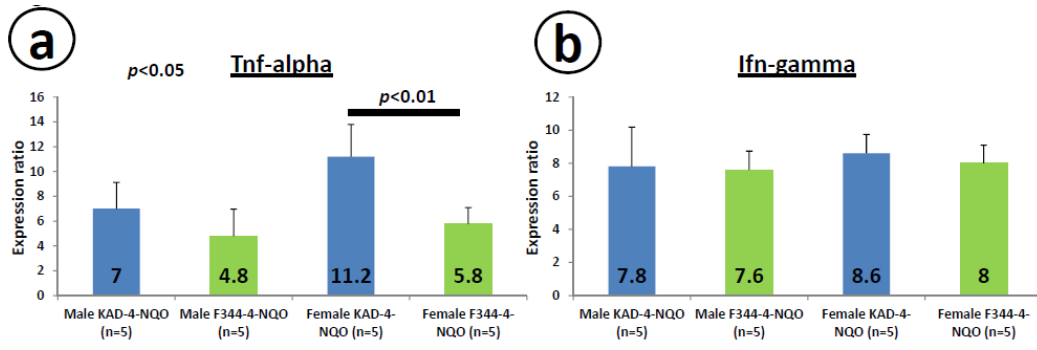
Figure 6. mRNA expression levels of pro-inflammatory cytokines ( a – f ) and inducible inflammation-related enzymes ( g , h ) in the tongue tissues of the KAD and F344/NS1c rats. Total RNA was extracted from the tongue tissues of untreated and 4-NQO-treated rats. The mRNA levels of ( a ) Tnf- α , ( b ) Ifn- γ , ( c ) Il-1 β, ( d ) Il-6 , ( e ) Il-17 , ( f ) KC ( Il-8 ), ( g ) iNos and ( h